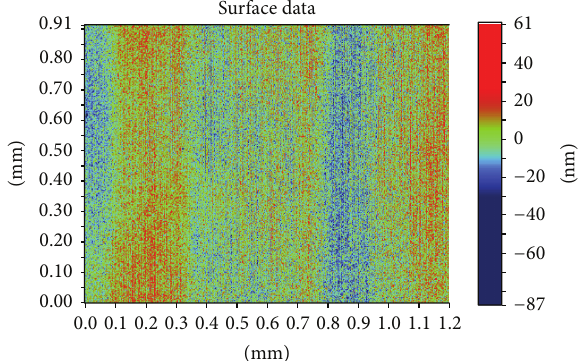
Figure 6: Surface morphology of the Cr layer tested with the optical